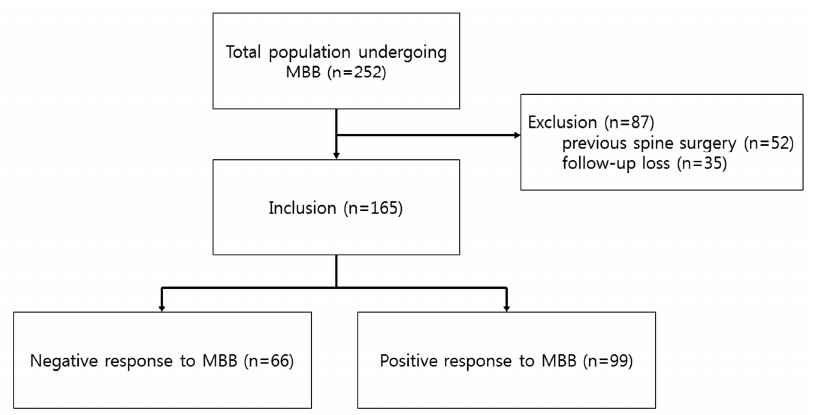
Figure 2. Flow diagram of the study procedure. MBB = Medial branch block.